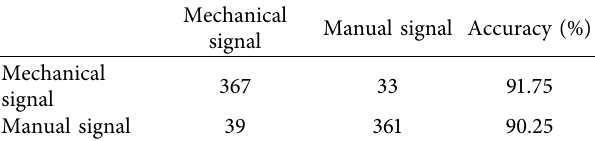
Table 3: SCN network recognition rate. Mechanical